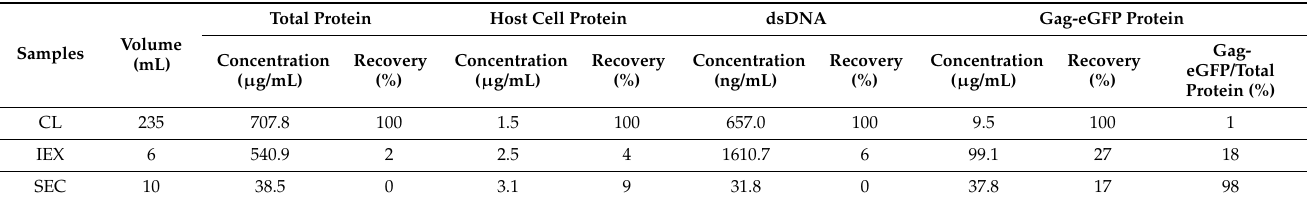
Table 1. Mass balance of total protein, HCP, dsDNA, and Gag-eGFP polyprotein. Cl: clarified material; IEX: E2 peak from EIX chromatography; SEC: SEC2 peak from SEC.